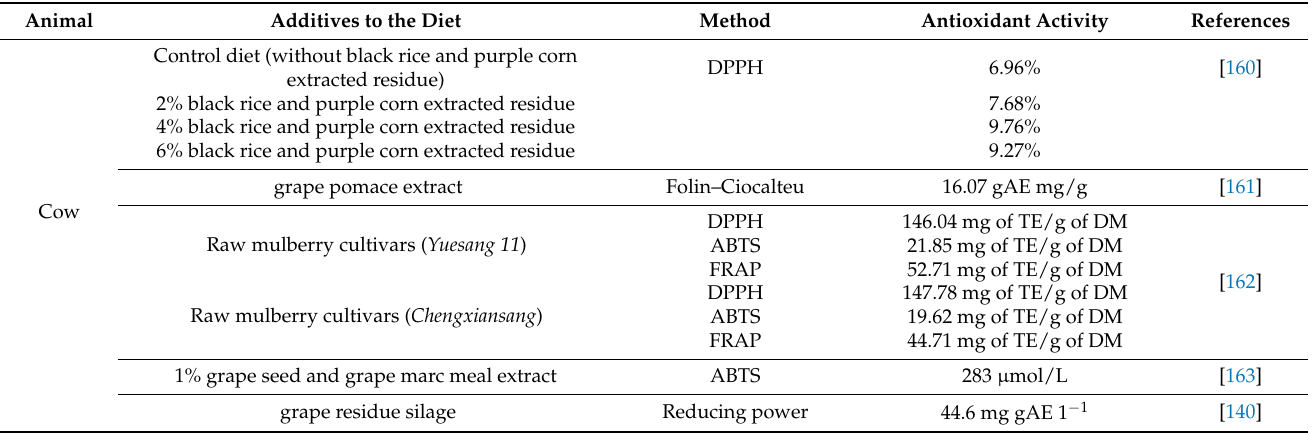
Table 4. Antioxidant activity of milk after supplementation of feed with natural plant additives (own work based on: